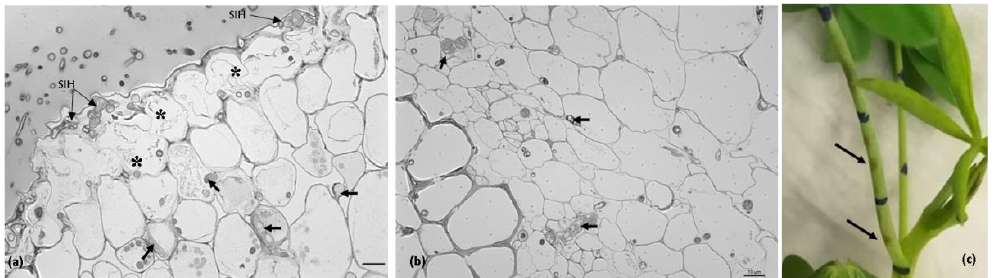
Figure 4. The Colletotrichum lupini infection process on petioles of Lupinus mutabilis and the corre- sponding macroscopic symptoms 4 days after inoculation. ( a , b ). Light microscopic observations, toluidine blue staining. ( a ). Infection sites showing subcuticular intramural hyphae (SIH) and hyphae developing intra- and intercellularly (arrows) in epidermal and cortex host cells. Note the intense degradation of the epidermal cell walls and those of the first layers of the cortex, and also the collapse or disruption of the cytoplasm of some of these infected cells (*). ( b ). Intra- and intercellular fungal growth (arrows) in cortex cells and vascular cells. Plant cell degradation is not so intense as observed in the epidermal cells and those of the first layers of the cortex cells (see Figure 2b). ( c ). Petioles exhibiting disease symptoms (arrows). Scale bar = 10 µm.